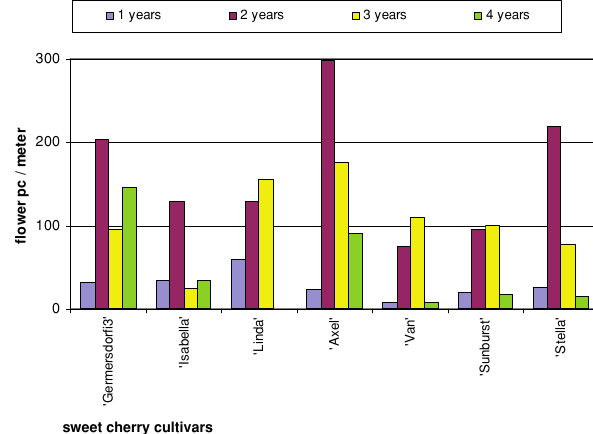
Figure 2: Number of flowers on fruiting parts of different age, one to four- year-old, in sweet cherry cultivars (Debrecen-Pallag, 2009)